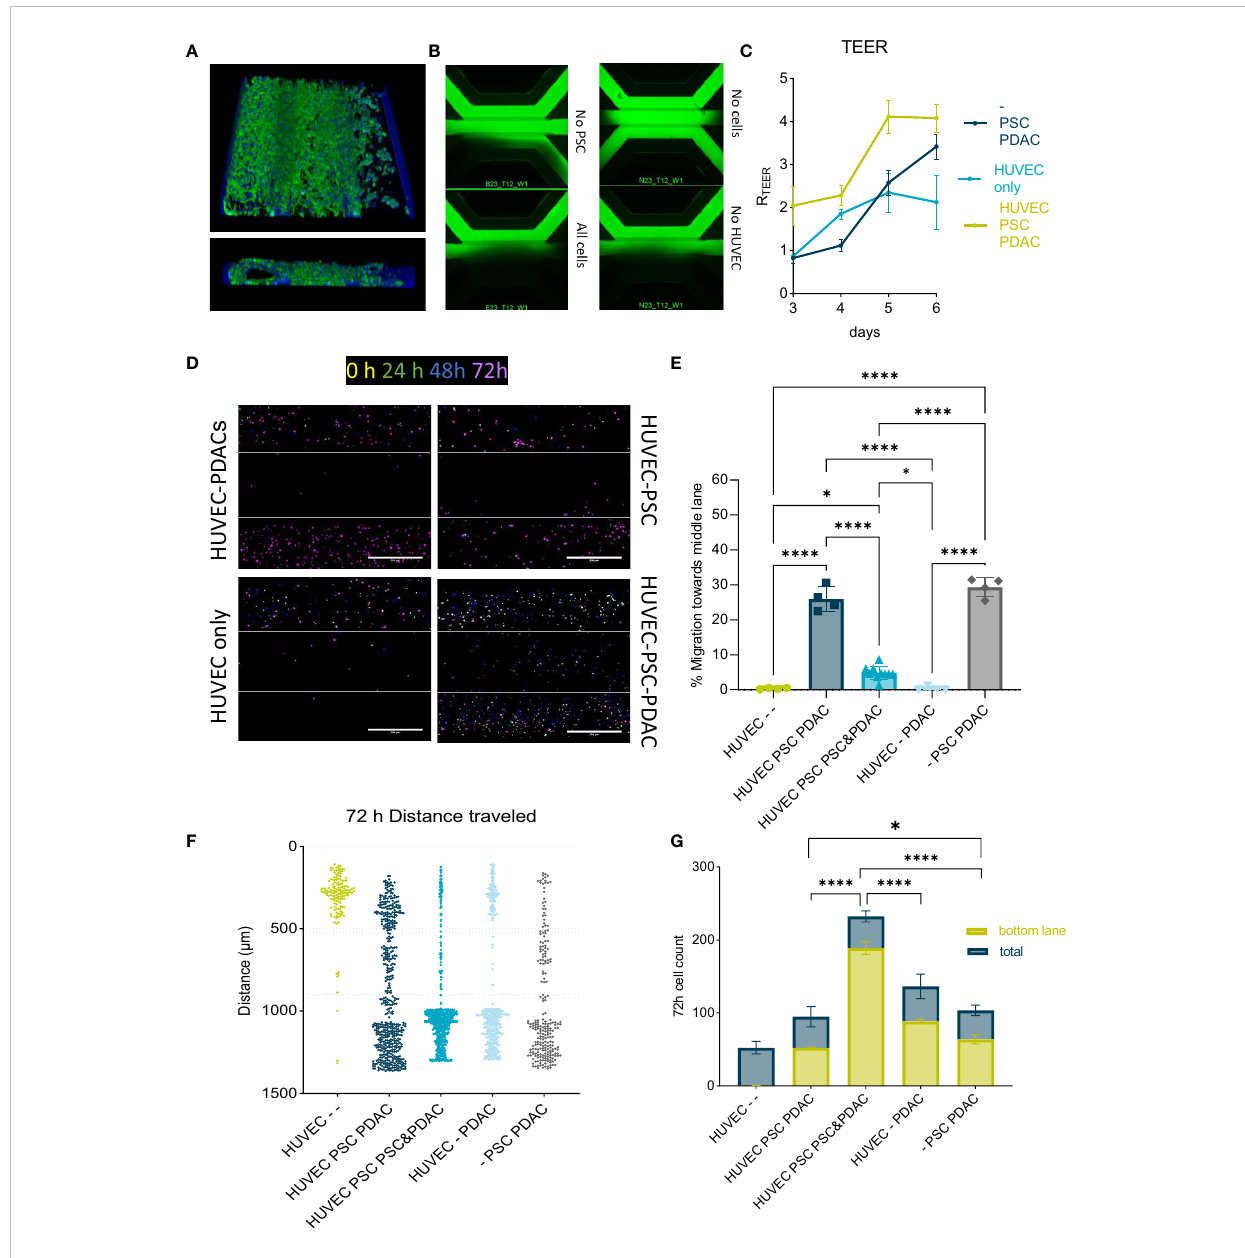
FIGURE 3 Migration of PBMCs in the PDAC TME model: (A) Top and side view of the 3D reconstruction of the complete model comprising a HUVEC tubule, PSCs and PDAC organoids. The cells were stained with Actin and NucBlue and imaged on the ImageXpress Micro Confocal (Molecular Devices) (B) BI-assay images of the tri-culture system. Perfusion of a 155k Da FIT-C labeled dextran, 4x magni fi cation. Images acquired on the ImageXPress Micro XLS Wide fi eld High-Content Analysis System ® (Molecular Devices). (C) TEER measurements highlighted the role of PSCs in increasing the barrier function of HUVEC tubules (N=3, n=3). Statistical analysis revealed *p<0,05 for the - PSC PDAC sample and *** p<0,001 for the HUVEC PSCs PDAC sample compared to the HUVEC only control on day 6. (D) CMRA staining of migrating PBMCs imaged on the ImageXpress Micro Confocal (Molecular Devices) at 0h, 24h, 48h and 72h after PBMC seeding. 10x acquisition, Scale bar=500 µm. (E) Quanti fi cation of PBMC numbers in the middle lane. Migration was analyzed with a cell counting tool in FIJI based in confocal images. Shown are mean± SD (N=3, n=3). Data show % of cells that migrated compared to the total amount of cells counted in the chip. (F) Migration chart showing the position of single PBMCs and distance they traveled in the OrganoPlate after 72h in different setups. Migration was analyzed with a cell counting tool in FIJI based on confocal imaging. Shown are mean+- SD (N=3, n=3). (G) Total cell number of immune cells migrated towards PDACs within 72h versus total number of cells within a chip. Shown are mean+- SD (N=3,